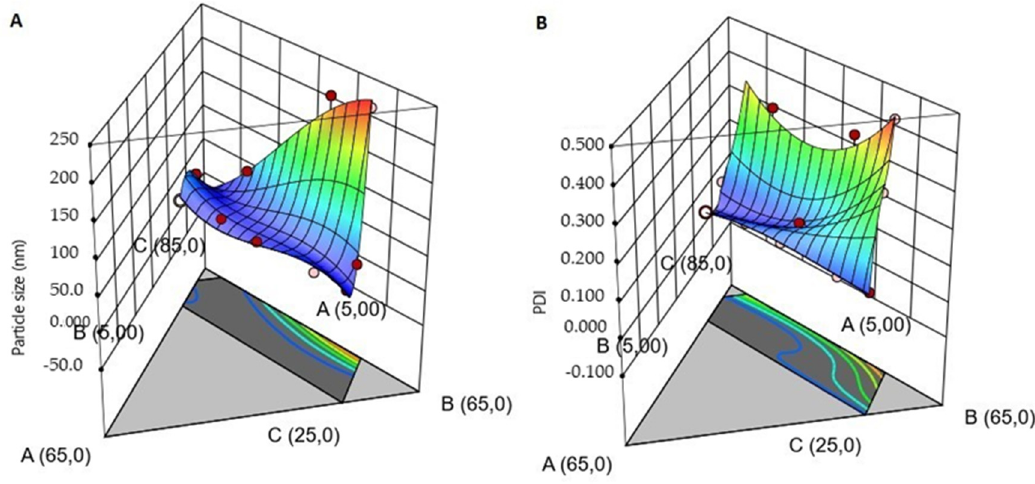
Figure 2. Three-dimensional surface plots interaction effect between the variables (Kolliphor™ RH40, Tween 80, Transcutol P and Water) on the response droplet size ( A ) and polydispersity index (PDI) ( B ).